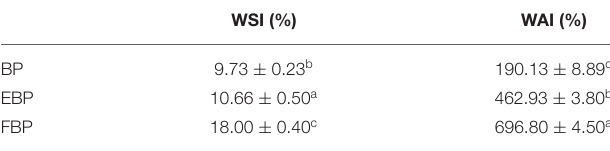
TABLE 3 | Free amino acids content (%) of BP, EBP, and FBP. BP